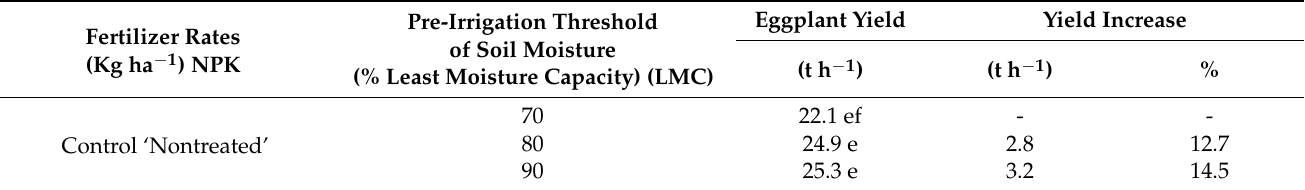
Table 4. Eggplant yield response to the level of pre-irrigation soil moisture and fertilizer application